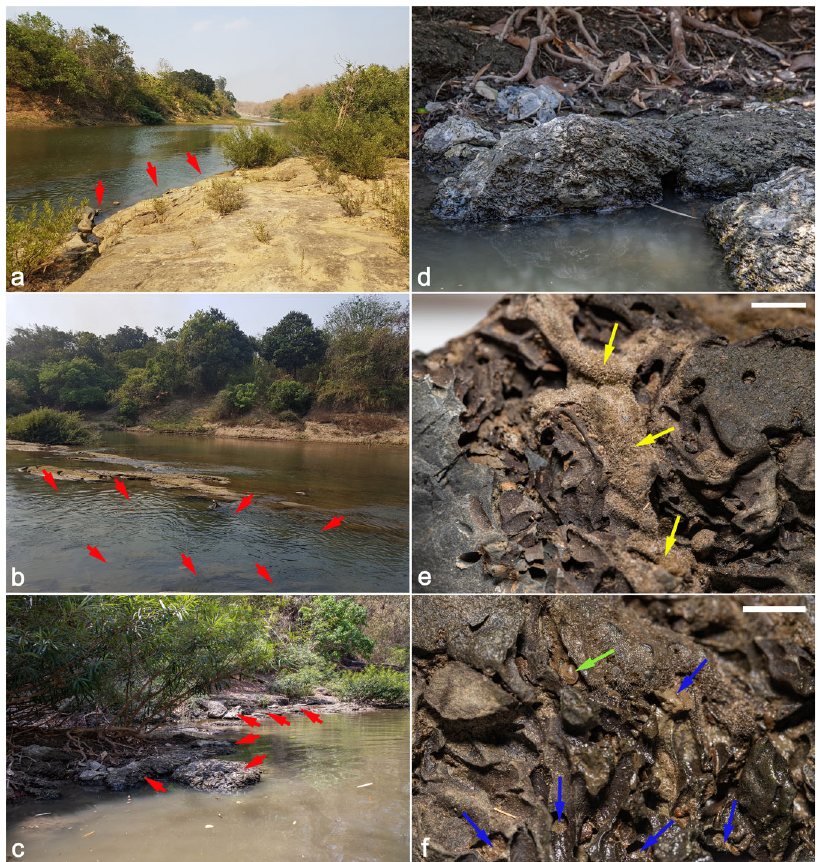
Fig. 2 Examples of macrobioerosion in the Bago River, Myanmar. a Right shore with continuous siltstone outcrop at the middle reaches of the river. The red arrows show the location of submerged rocks with bioerosion traces. b Submerged part of the siltstone rock outcrop (indicated by the red arrows) at the middle reaches of the river. c Emerged siltstone rocks with bioerosion traces (indicated by the red arrows) at the upper reaches of the river. d Close-up view of siltstone outcrop with multiple bioerosion traces at the upstream section of the river. e Siltstone fragment densely covered by sub-recent bioerosion traces from the upper reaches of the river (plan view). The yellow arrows show crusts of a freshwater sponge species. f Siltstone surface with a dense network of sub-recent bioerosion traces from the upper reaches of the river (plan view). The blue arrows show the macroborings fi lled with clay. The green arrow shows a pea clam in a bioerosion groove (Bivalvia: Sphaeriidae). Scale bars = 10 mm ( e , f ). (Photos: Mikhail Y. Gofarov [ a – b ] and Ilya V. Vikhrev [ c – f